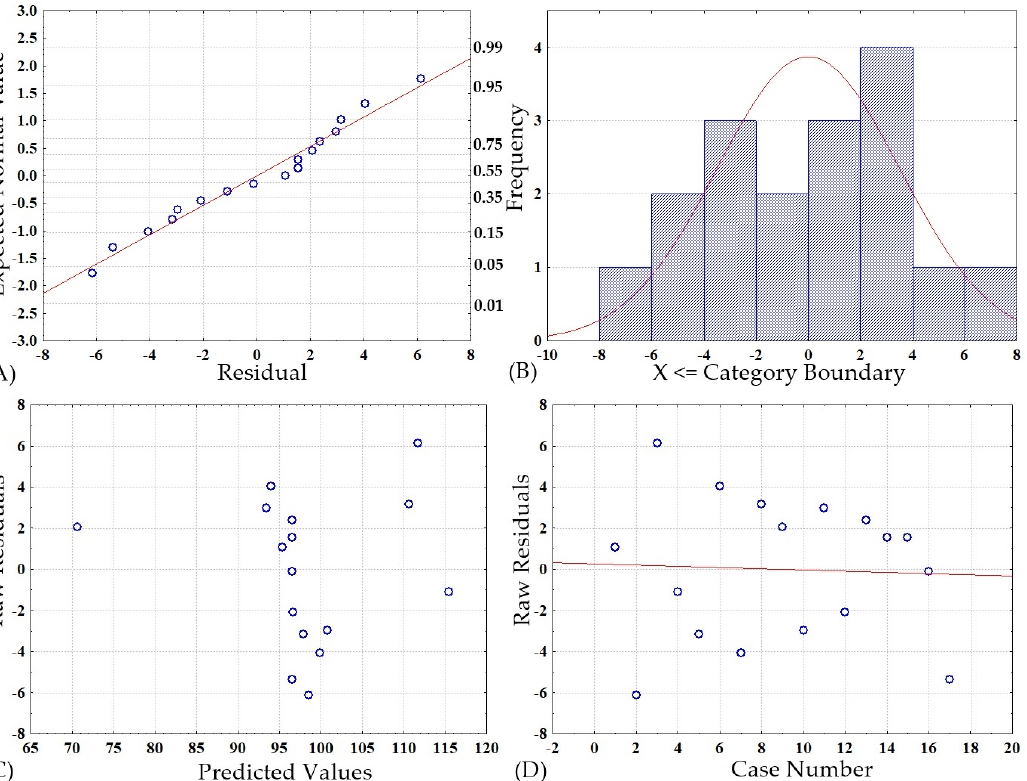
Figure 2. Residue analysis for xylanase extraction performed in an aqueous two-phase system based on sodium citrate dihydrate to obtain the highest possible extraction efficiency value: ( A ) residue plot, ( B ) histogram, ( C ) ratio of predicted value to residue values, and ( D ) comparison of experimental and residue values.